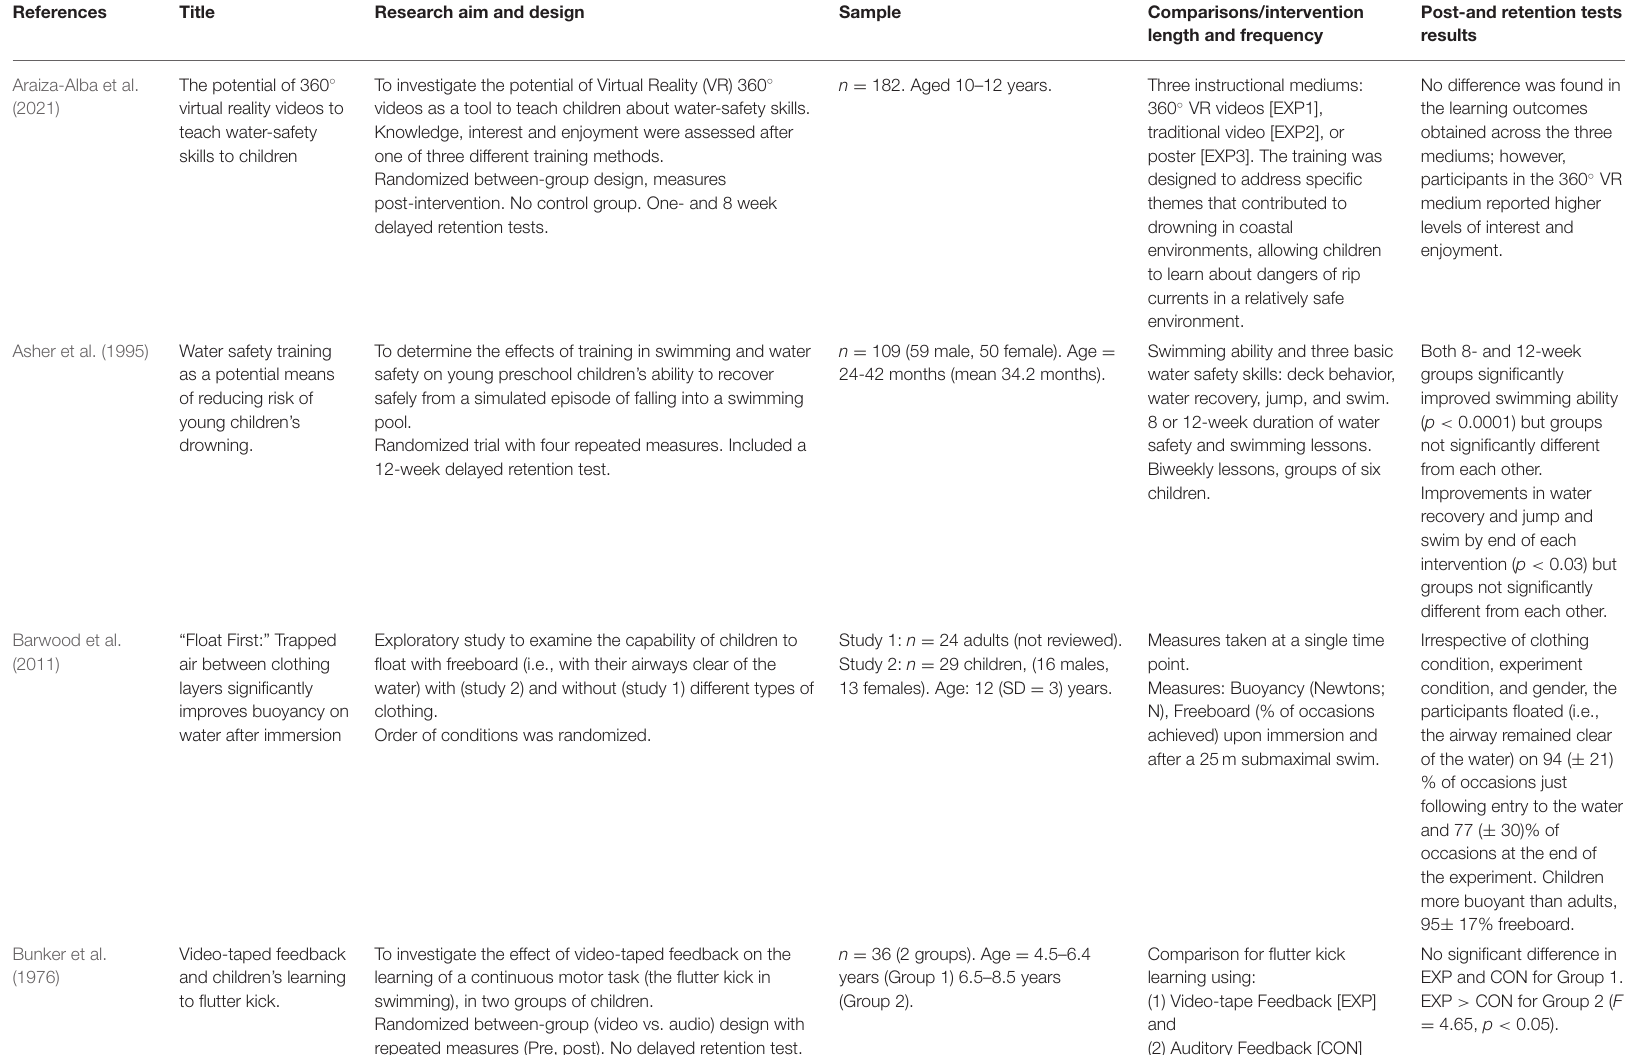
TABLE 1 | Overview of reviewed empirical research studies ( N =